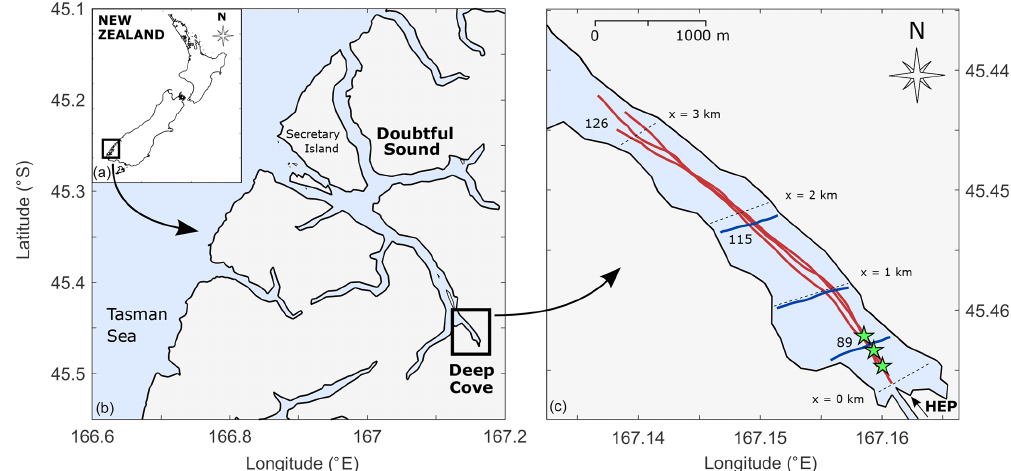
Figure 1. Location map of (a) New Zealand with the Fiordland region highlighted, (b) Doubtful Sound identifying the location of (c) Deep Cove showing the repeated across-channel (blue) and along-channel (red) vessel transects taken on three separate days in March 2016. The sampling started at the tailrace exit point and continued downstream towards the seaward end of Deep Cove. The mooring locations (stars) are shown. The arrow at the bottom right of panel (c) indicates the tailrace inflow from the Manapouri hydroelectric power station (HEP) discharged into the head of Deep Cove. The dashed lines across the fjord are reference distances from the tailrace discharge point ( x = 0, 1, 2, 3km) and are referenced in the text and in other